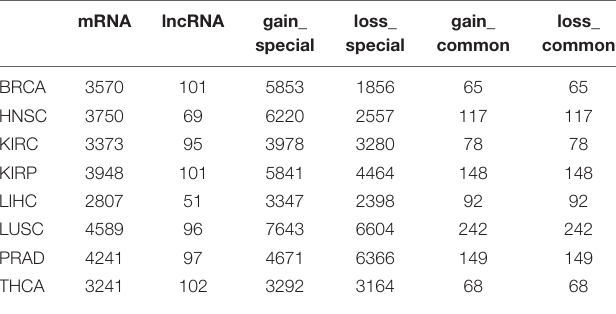
TABLE 1 | Statistics of nodes and edges in the ceRNA dysregulated network across eight cancer